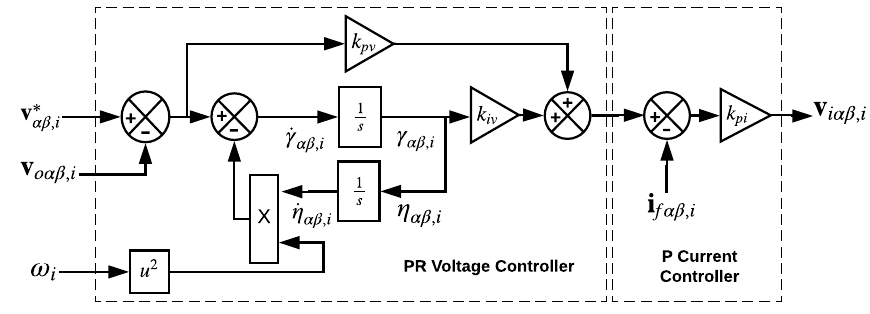
Figure 5. PR-P Inner